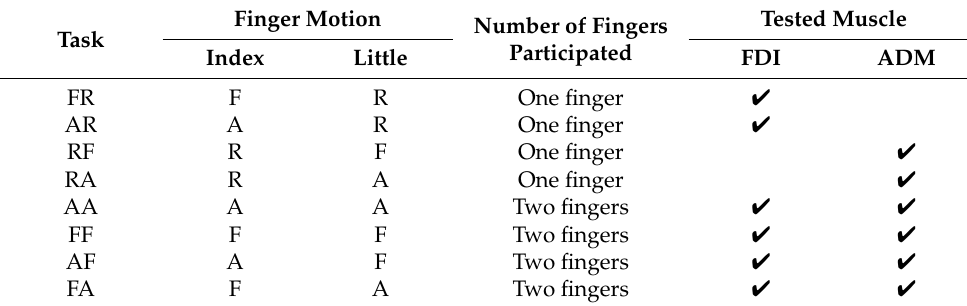
Table 1. Motor tasks.